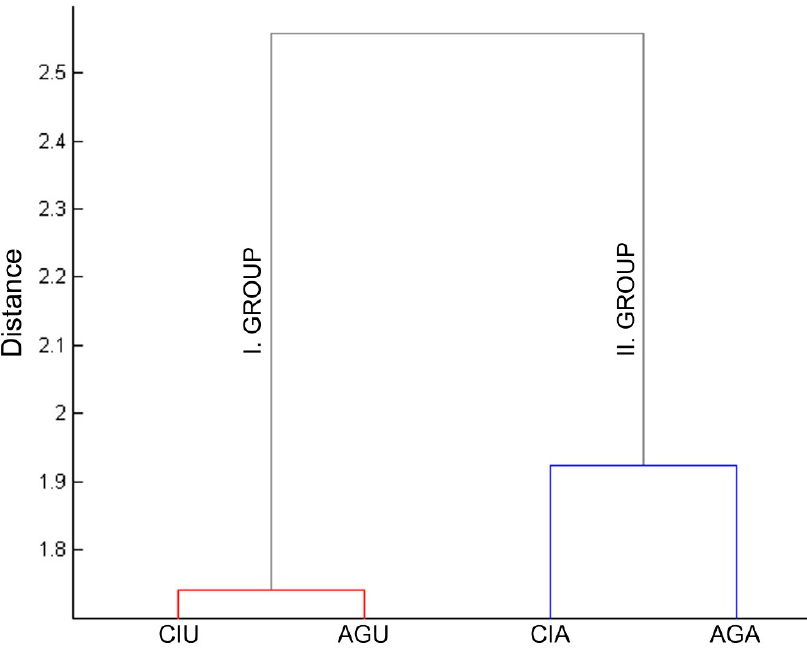
Figure 2. Dendrogram presenting the results from the hierarchical cluster analysis on the response function coe ffi cients of the four site chronologies.